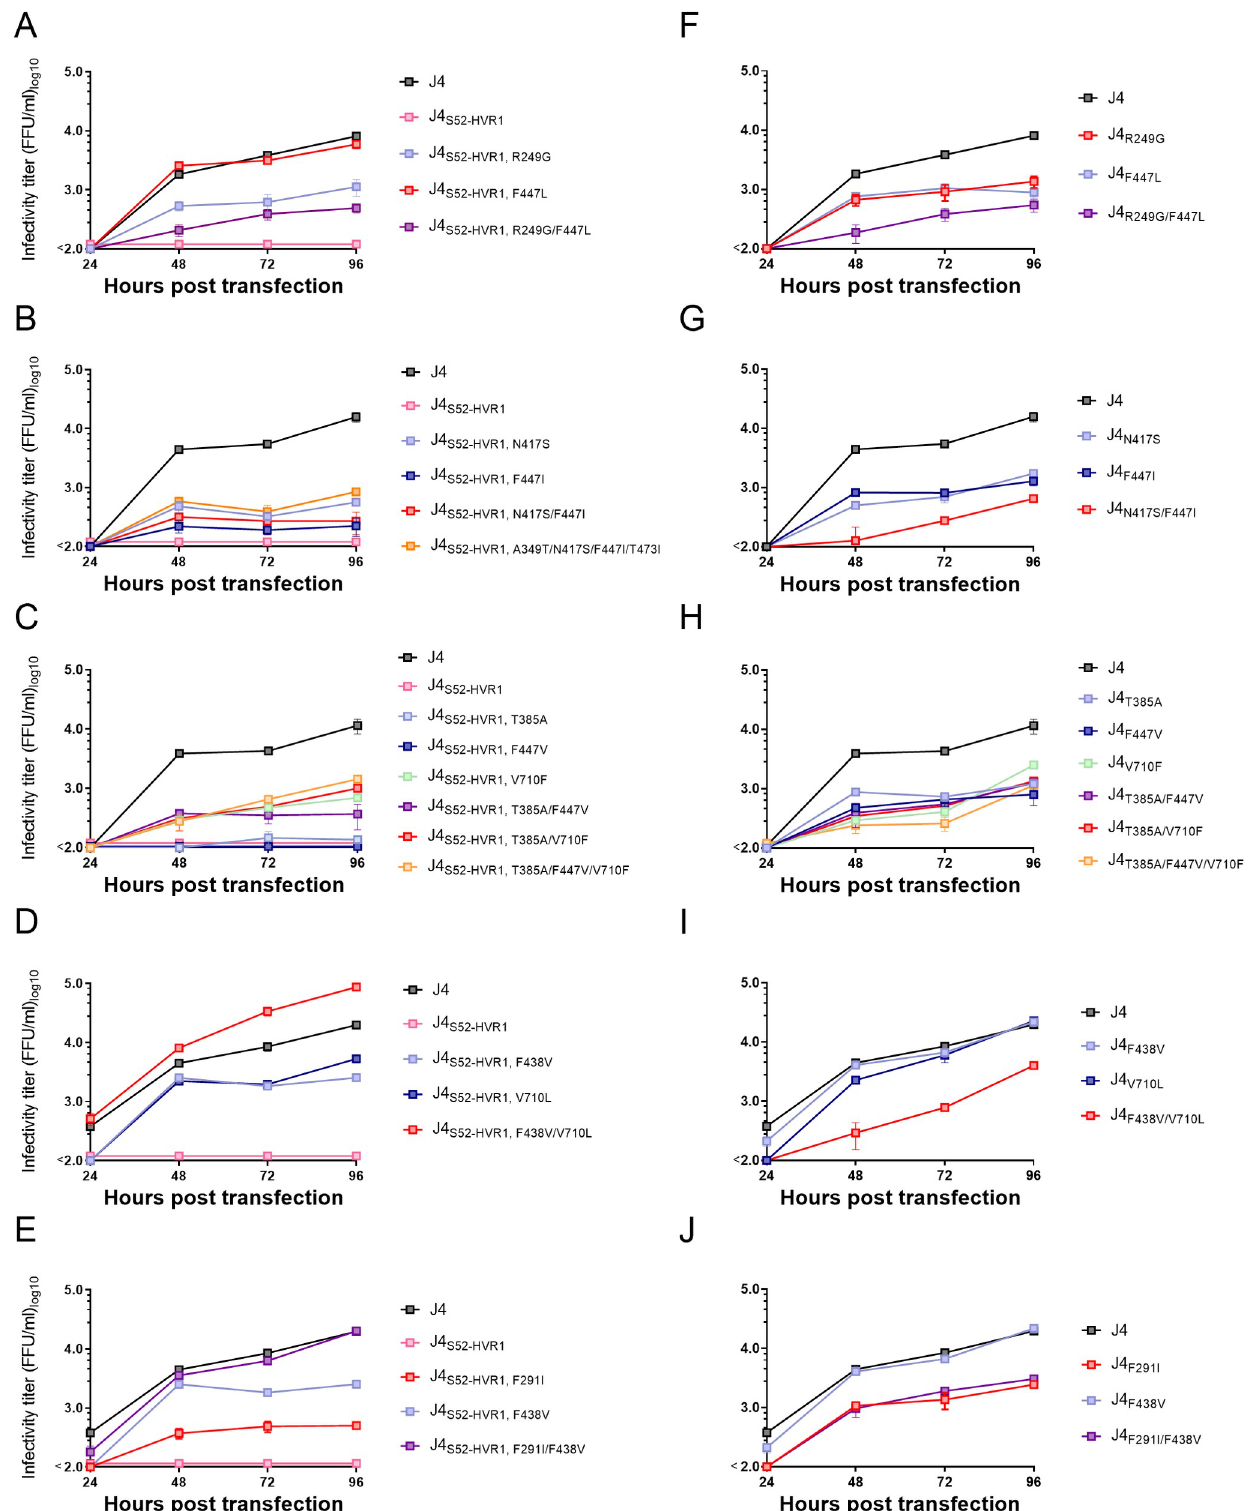
Fig 6. J4 S52-HVR1 requires specific substitutions in E2 to regain infectivity. Huh7.5 cells were transfected with in vitro transcribed HCV RNA of the indicated recombinants. Supernatants were collected 24, 48, 72 and 96 hours post transfection and HCV infectivity titers were determined. At